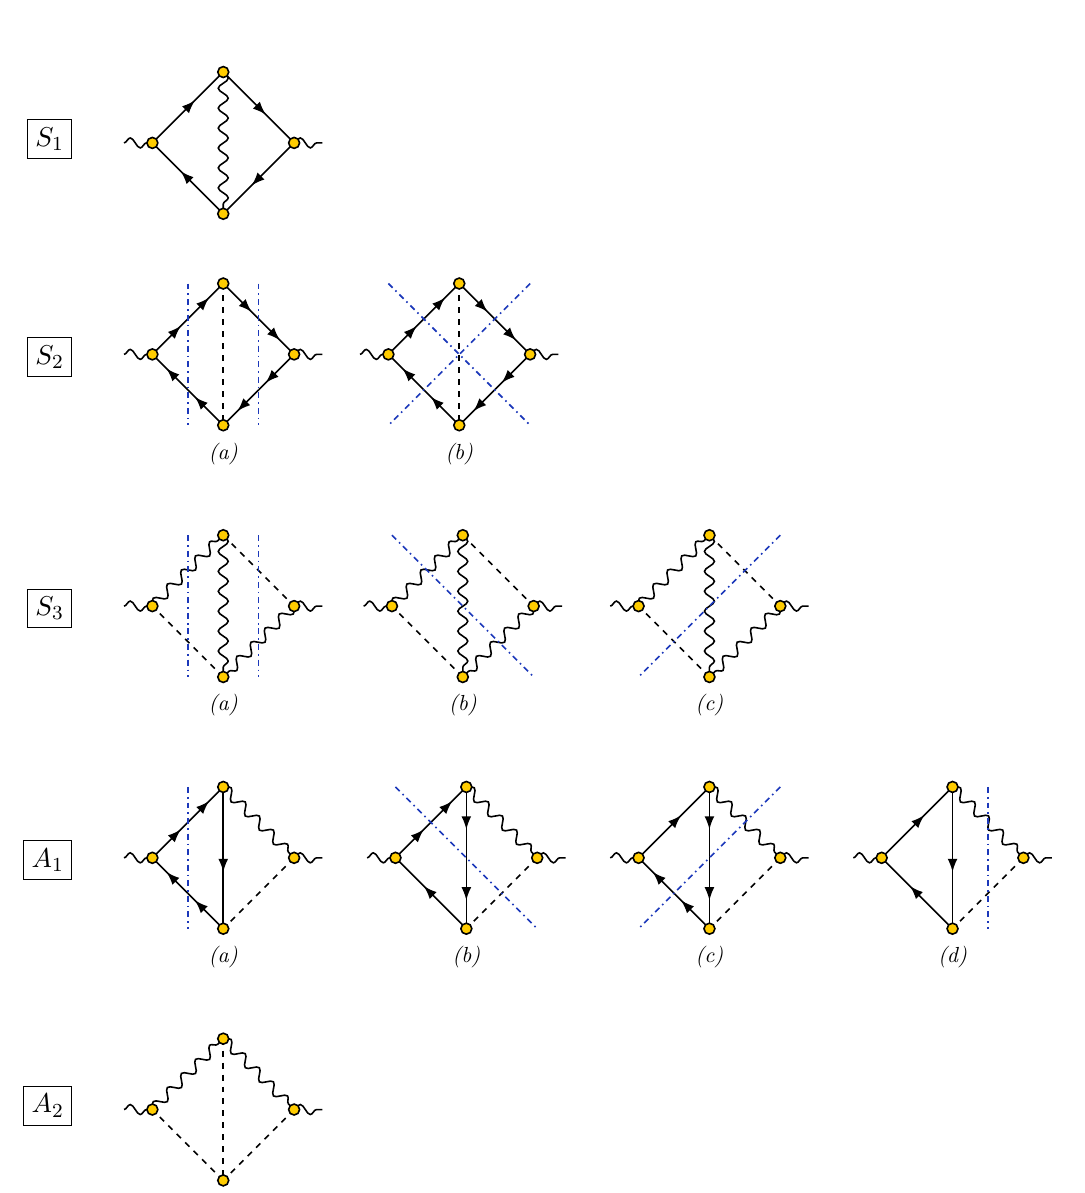
Figure 3 . Unitarity cuts contributing to various two-body decay channels (virtual corrections) and three body channels (real emissions). Dashed lines represent the light Higgs boson h (both real and virtual, depending on the specific diagram considered). In virtual corrections, Z internal lines represent the sum over the Feynman Z propagator and the Goldstone φ propagator. In the case of real Z emission, we sum over transverse and longitudinal polarizations. We collect all analytical expressions for the various diagrams contributing to each bubble in appendix D. As a side comment, notice that we named with S the diagrams S ymmetric under reflection over the center of each i =1 , 2 , 3 bubble, while the rest of the diagrams are named A i =1 , 2